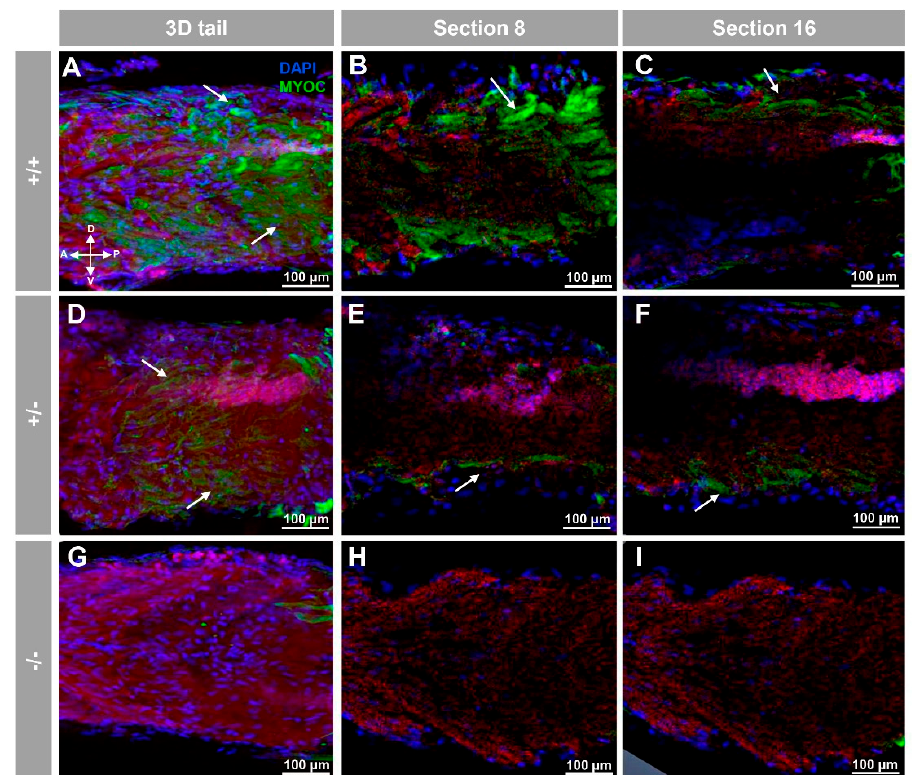
Figure 4. Fluorescent whole-mount immunohistochemical detection of myoc in the tail of zebrafish embryos (96hpf). Wild-type ( A – C ), heterozygous ( D – F ) and homozygous ( G – I ) myoc mutant embryos were incubated with a chicken anti-myocilin (TNT) primary antibody and a Cy2-conjugated goat anti-chicken IgY secondary antibody. Three-dimensional reconstruction from z-stack scanned confocal microscopy images ( A , D , G ) of the tail. Sections (92 µm) 8 ( B , E , H ) and 16 ( C , F , I ) were selected from z-stack images to show the precise localisation of the green signal in the tail’s skin (arrow) ( A – C ). Blue: DAPI nuclear staining. Green: Cy2-conjugated goat anti-chicken IgY secondary antibody. Red: tissue autofluorescence. The cross indicates the position of the embryonic axes (D: dorsal; P: posterior; V: ventral; A: anterior). The images are representative of the results observed in ten embryos. The negative controls are shown in Figures S3G–I.